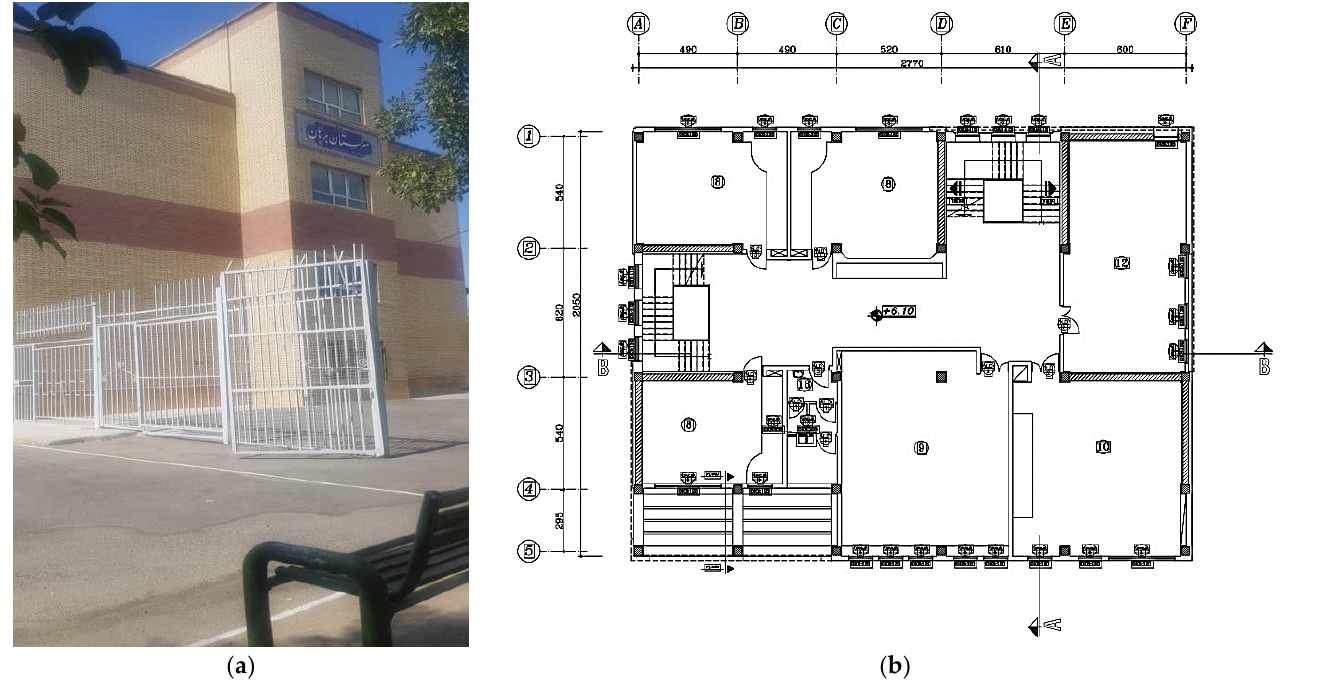
Figure 6. ( a ) The east view of the studied case. ( b ) The first-floor